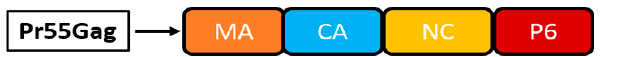
Figure 2. Gag protein components. The structural protein Gag is mainly processed into four proteins, p17 matrix (MA), p24 capsid (CA), p9 nucleocapsid (NC), and P6, by a virus-encoded p17 matrix (MA), p24 capsid (CA), p9 nucleocapsid (NC), and P6, by a virus ‐ encoded protease.